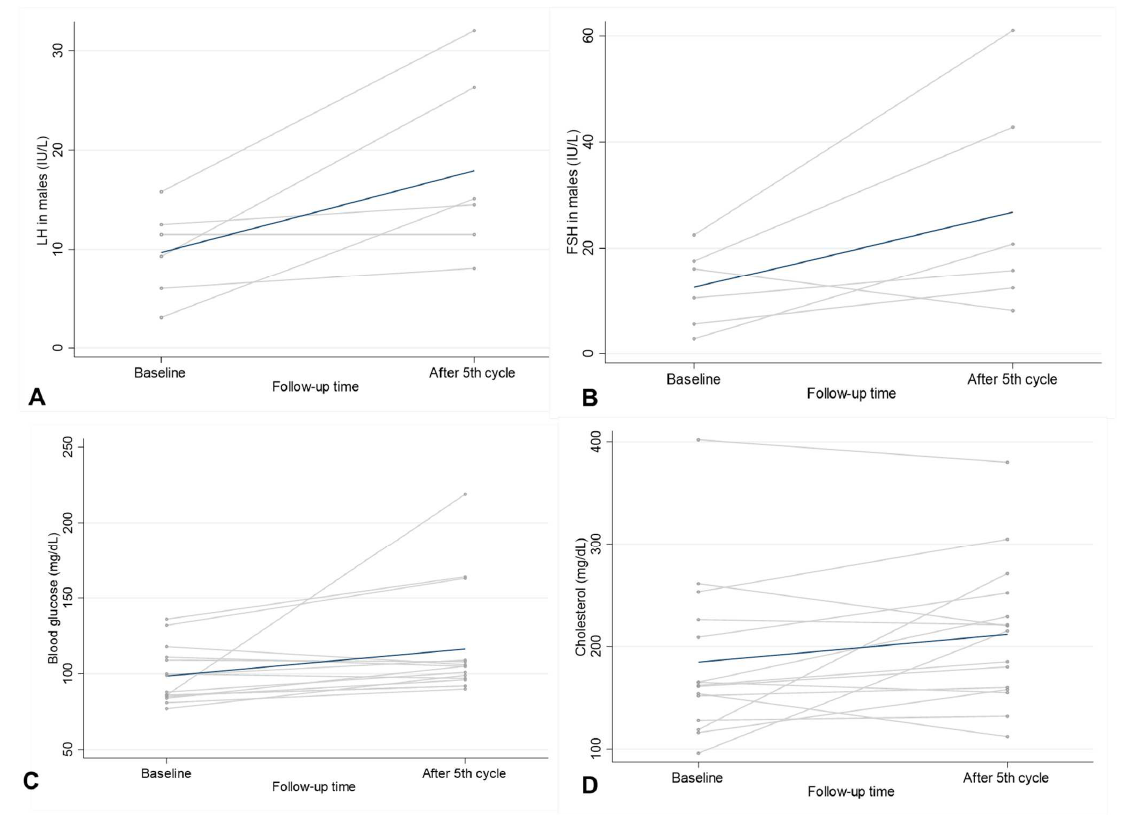
Figure 2. Trend of hormonal and metabolic changes at baseline and after 5th R-CHOP chemother- apy. ( A ) LH in males, ( B ) FSH in males, ( C ) blood glucose, and ( D ) cholesterol. ( A ) LH in males, ( B ) FSH in males, ( C ) blood glucose, and ( D )